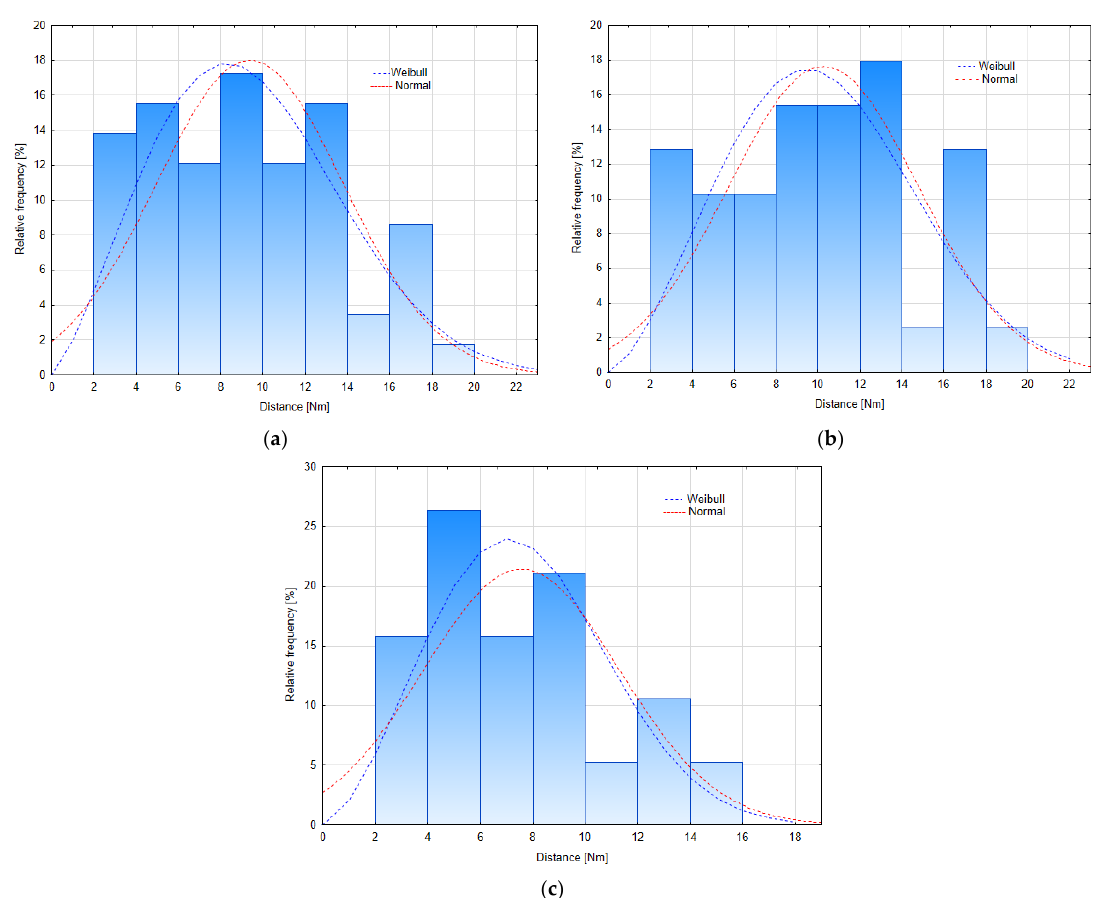
Figure 1. Histograms of the distance between ships at the start of the anti-collision manoeuvre and the best fitted theoretical distributions for all situations ( a ) in the open sea area ( b ) and in the restricted sea area ( c ).